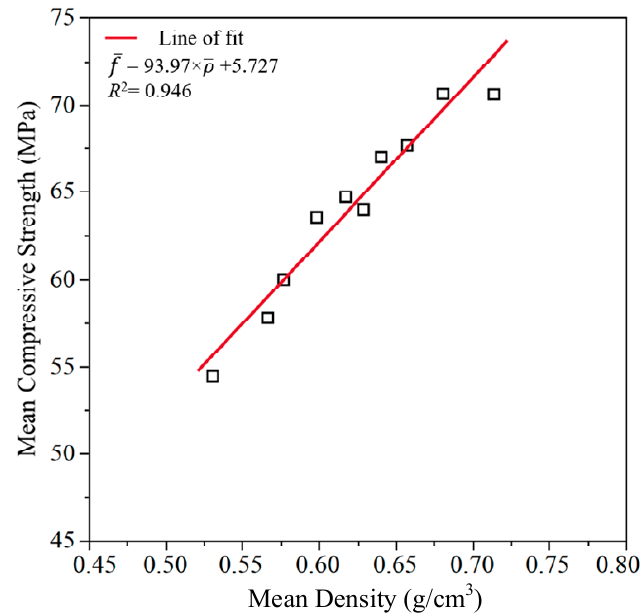
Figure 9. Relationship between the average compressive strength and density of the lamina grouped by density.